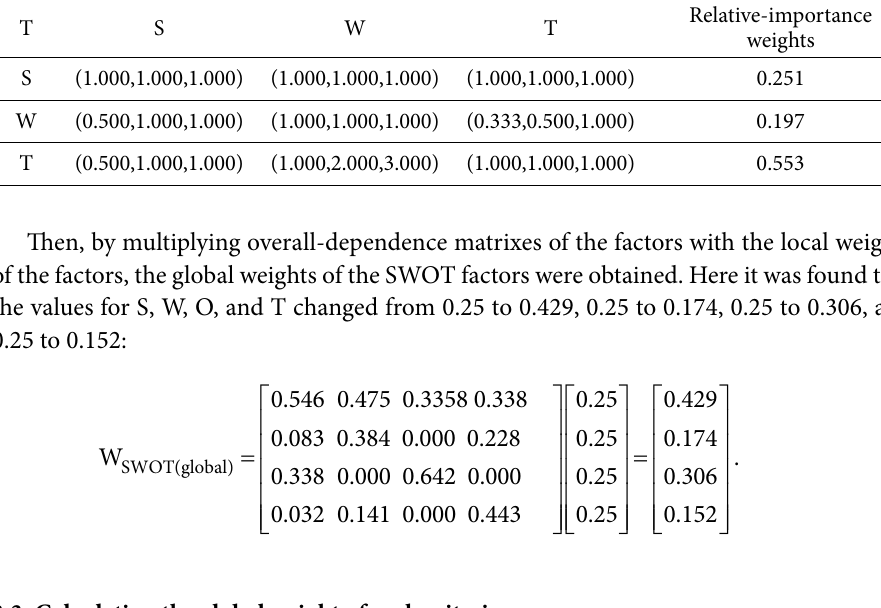
Table 7. The relative-importance weights for the “T” factor